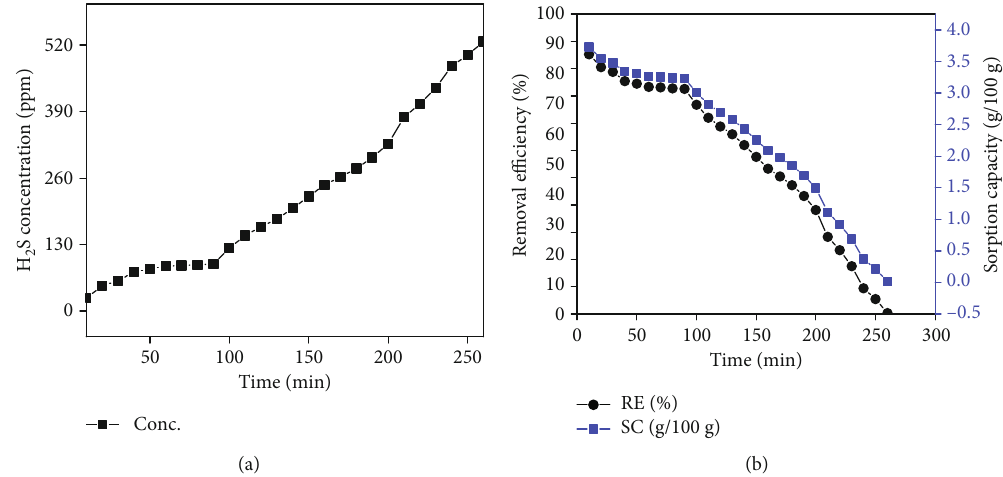
= 800 ° C , FR = 0 : 02m 3 /h , c